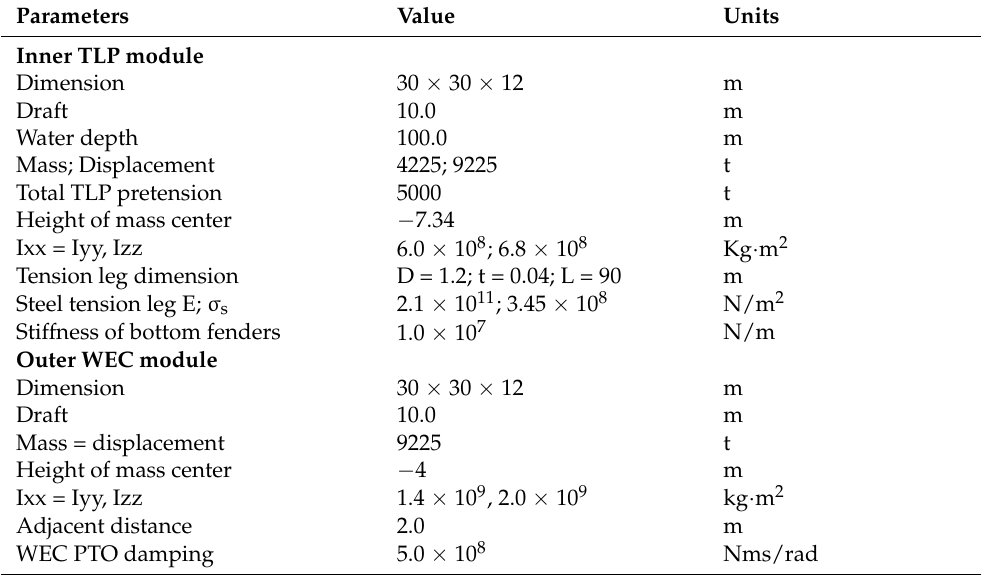
Table 1. Main design parameters of the simplified 7-module MTLPW